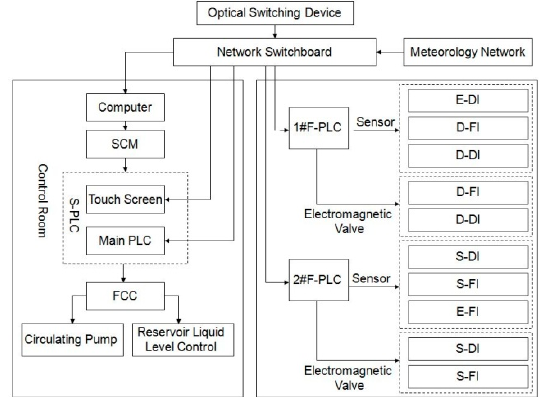
Figure 2. Network structure of Decision Support System for Irrigation Scheduling (DSSIS). SCM, Single Chip Microcomputer; PLC, programmable logic controller; S-PLC, the site of programmable logic controller; FCC, frequency conversion controller. D-FI and D-DI, the DSSIS system using an RZWQM2 model simulated water stress under full irrigation and deficit irrigation; S-FI and S-DI, sensor–based full irrigation and deficit irrigation; E-FI and E-DI, experience-based full irrigation and deficit irrigation.